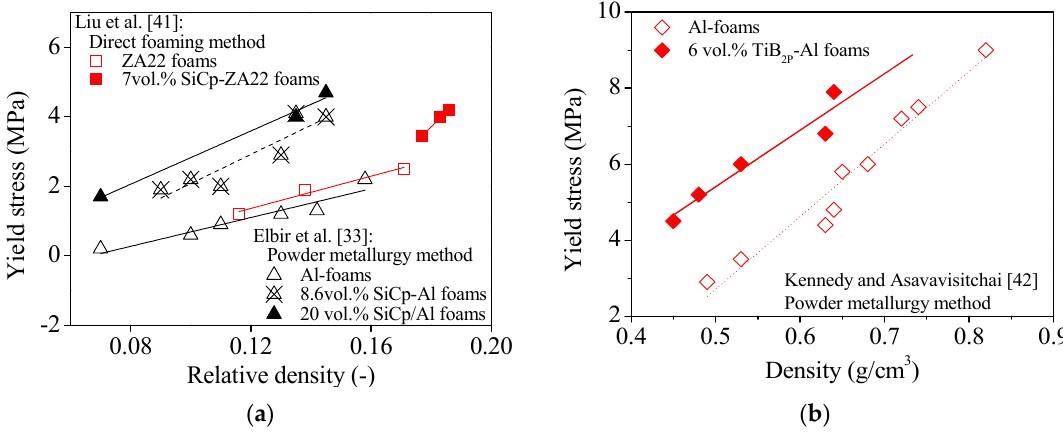
Figure 1. Effect of the volume fraction of SiC ( a ) and TiB 2 ( b ) particles on the yield stress of Al based foams.